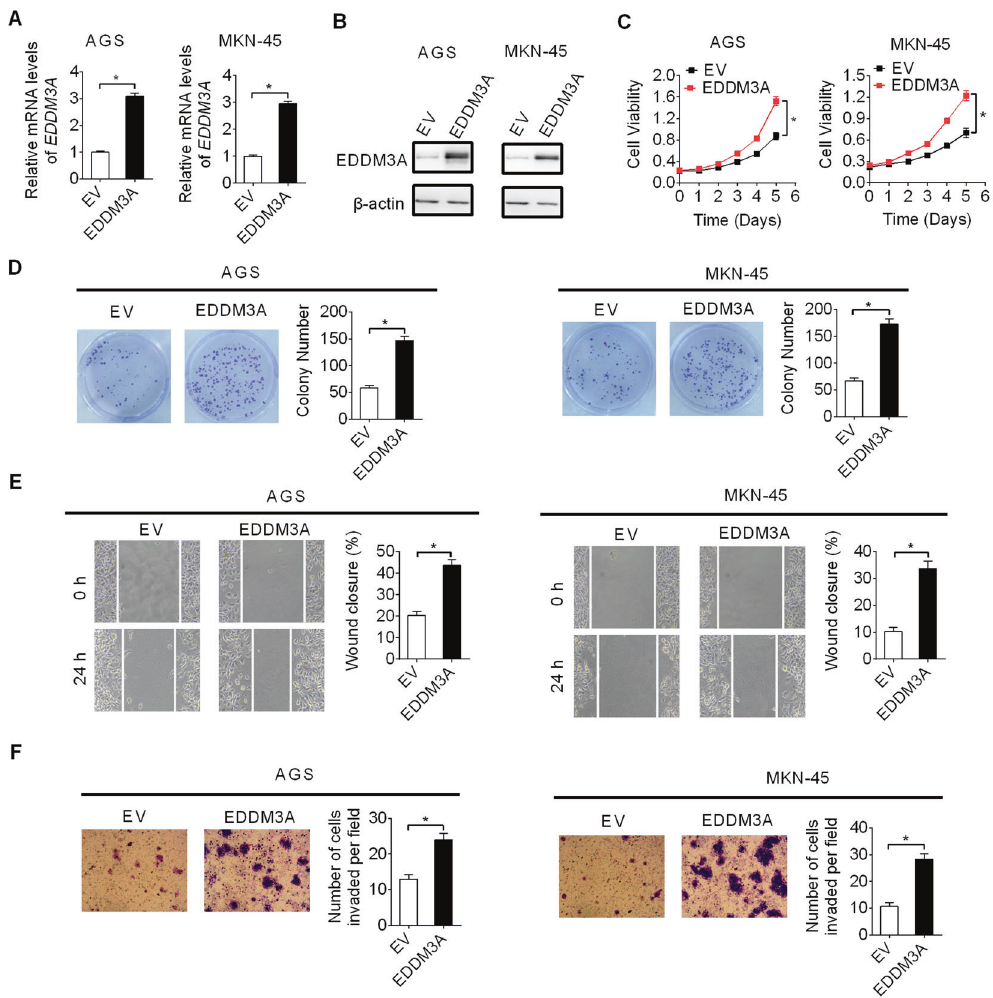
Fig. 4 Ectopic expression of EDDM3A promoted GC growth and metastasis. A , B Forced expression of EDDM3A was con fi rmed by qRT-PCR and western blot assays in AGS and MKN-45 cells. C , D Effects of EDDM3A overexpression on cell viability and colony formation abilities